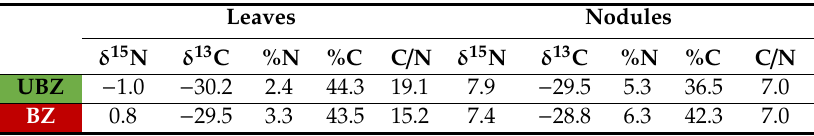
Table 2. Nitrogen and Carbon isotopic composition from leaves and nodules of A. longifolia young plants from unburnt (UBZ) and burnt (BZ) zones. The N and C isotopic compositions, δ 15 N and δ 13 C, respectively, and the percentage of these elements in leaves and nodules by % N and % C, as well as the ratio C / N are also shown. Di ff erences were not statistically significant, according to t -test with an α = 0.05. Leaves Nodules δ 15 N δ 13 C %N %C C / N δ 15 N δ 13 C %N %C C / N UBZ − 1.0 − 30.2